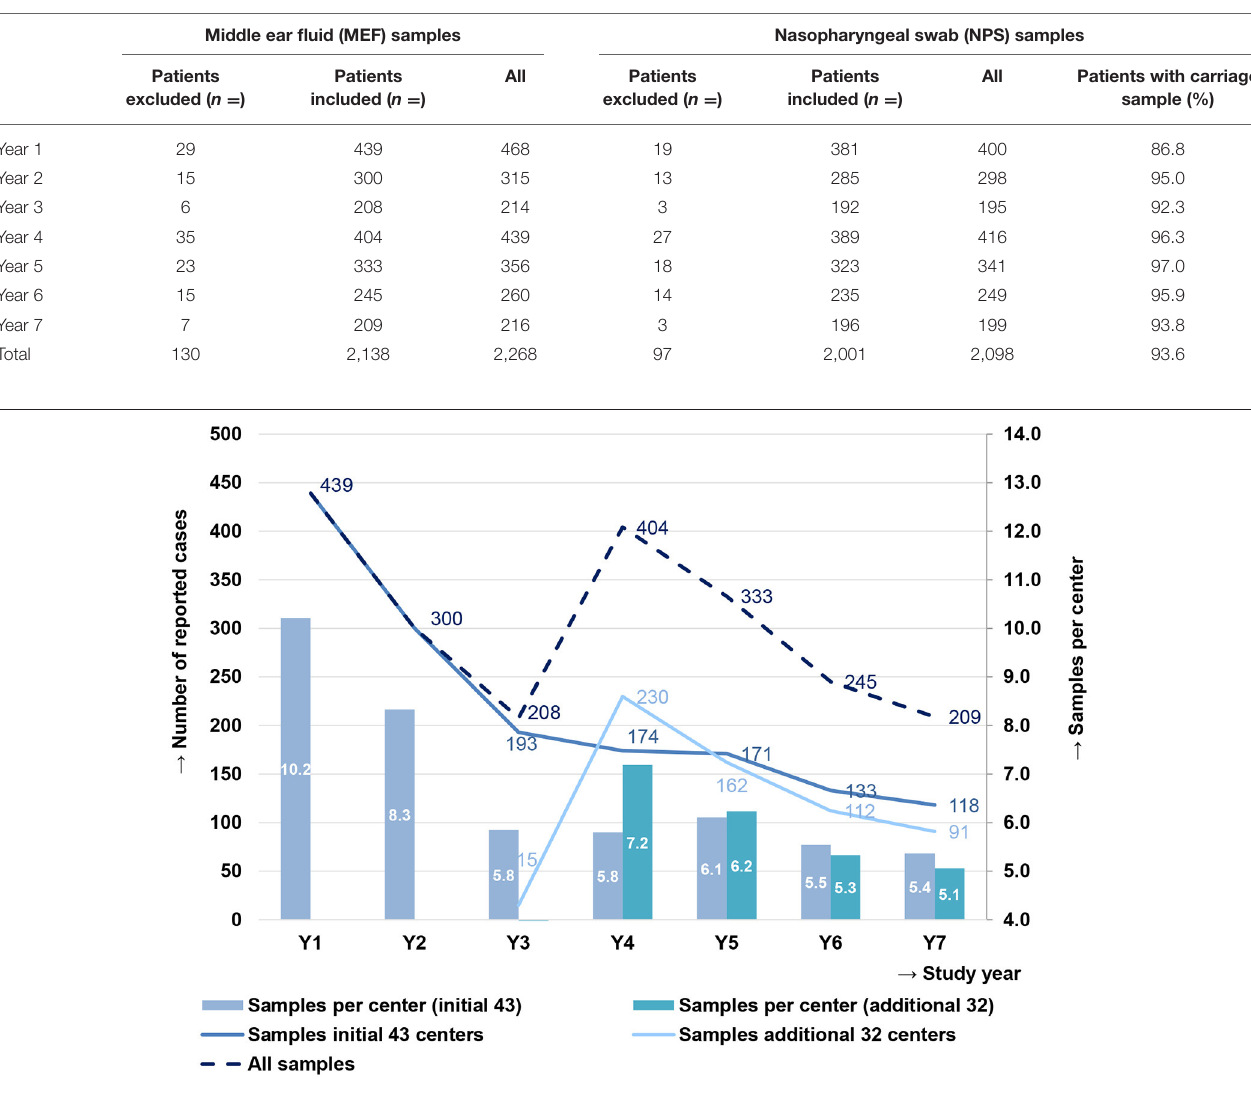
TABLE 1 | Numbers of MEF and NPS samples from patients with severe spontaneously ruptured AOM in Germany per study year. Middle ear fluid (MEF)